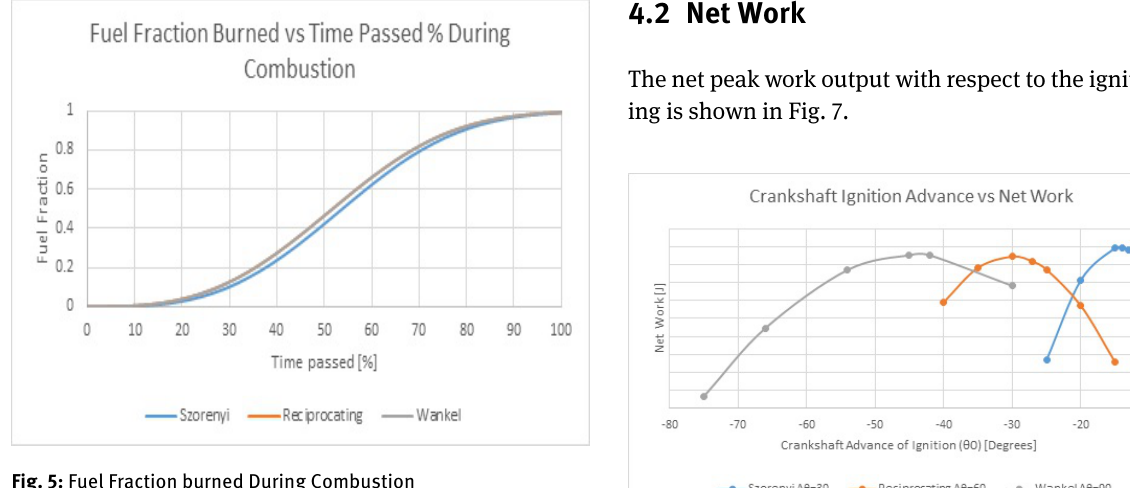
Fig. 5: Fuel Fraction burned During Combustion